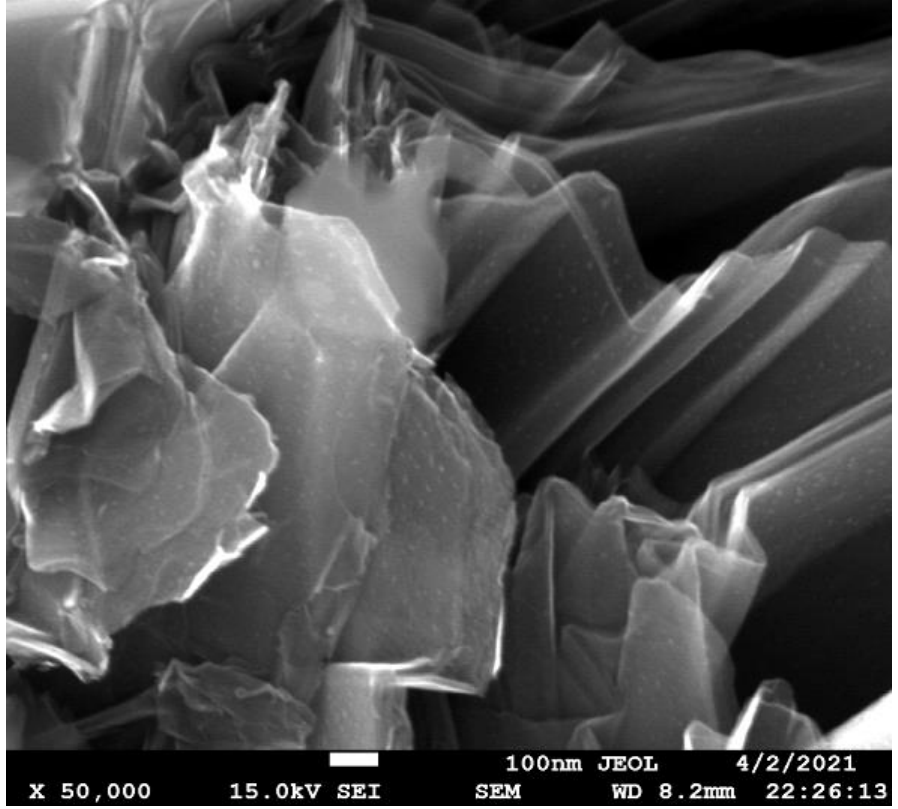
Figure 6. SEM image (secondary electrons) of the BN nanosheets formed near the TiB 2 grain. Raman spectra of the TiB 2 -BN-C ceramics obtained from the fracture surface are pre- sented in Figure 7. Since the TiB 2 phase is not Raman active, only h -BN and C components can be observed. The characteristic Raman G peak at 1360 cm −1 is a fingerprint of h -BN, which appears due to in-plane vibrations between B and N atoms [43]. Relatively high peak intensity suggests a multilayer h -BN configuration. Other observed features in the Raman spectra at 454, 1309, 1580, and 2680 can be assigned to sp- and sp 2 -bonded carbon. The Raman spectrum of graphite has a main band at 1580 cm −1 (D peak) and a small fea- ture at 2687 cm −1 (denoted as 2D or G’ peak). Multilayer graphene has additional bands at 1333–1349 and 1604–1618 cm −1 [44,45]. These modes are Raman active in defective gra- phitic materials. In addition, unlike a singlet peak in graphene, the 2D band in multilayer graphene appears as a doublet [46]. The intensity of the second peak in the doublet at approximately 2913 nm −1 , which is a characteristic of the disorder [47], is very small. Low- frequency peaks observed at 454 cm −1 can be attributed to bending modes of sp-coordi- nated carbon nanostructures [48].